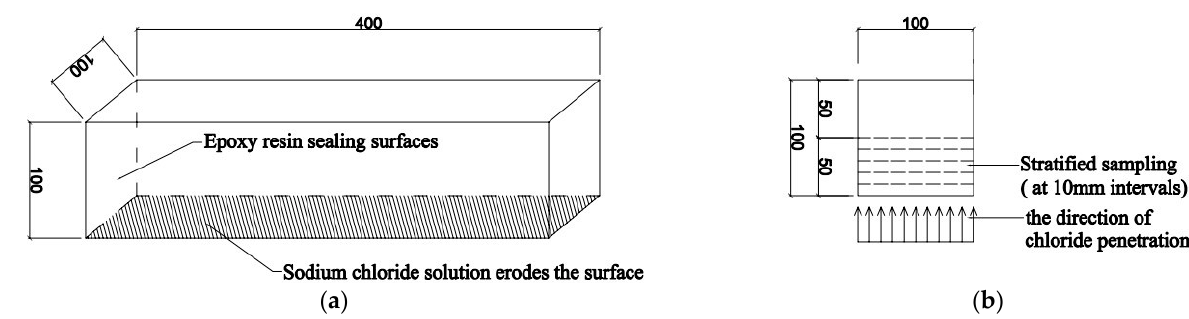
Figure 2. Schematic diagram of sampling for water-soluble chloride content test. ( a ) Schematic of test block for salt-freeze test. ( b ) Cross-section view of stratified sampling.